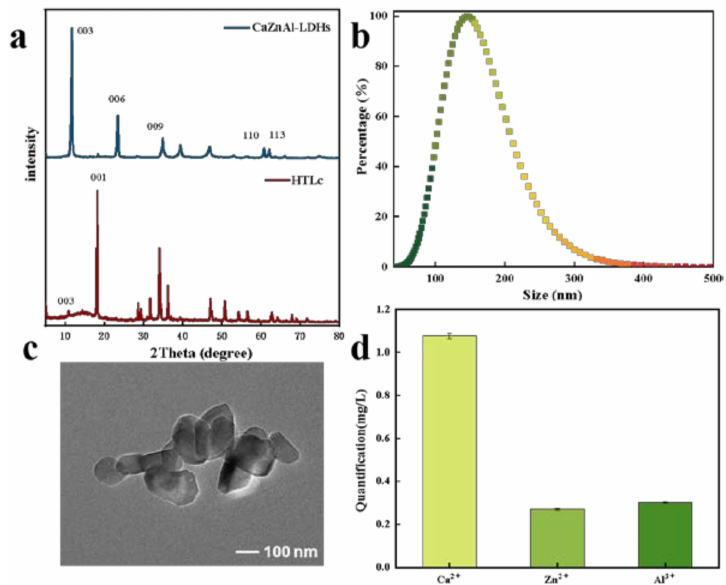
Figure 1. Characterisation of CaZnAl-CO 3 -LDHs: ( a ) XRD patterns of CaZnAl-CO 3 -LDHs and HTLc. ( b ) The particle size distribution of CaZnAl-CO 3 -LDHs platelets. ( c ) TEM images of CaZnAl-CO 3 -LDHs. ( d ) The content of Ca 2+ , Zn 2+ , Al 3+ in the CaZnAl-CO 3